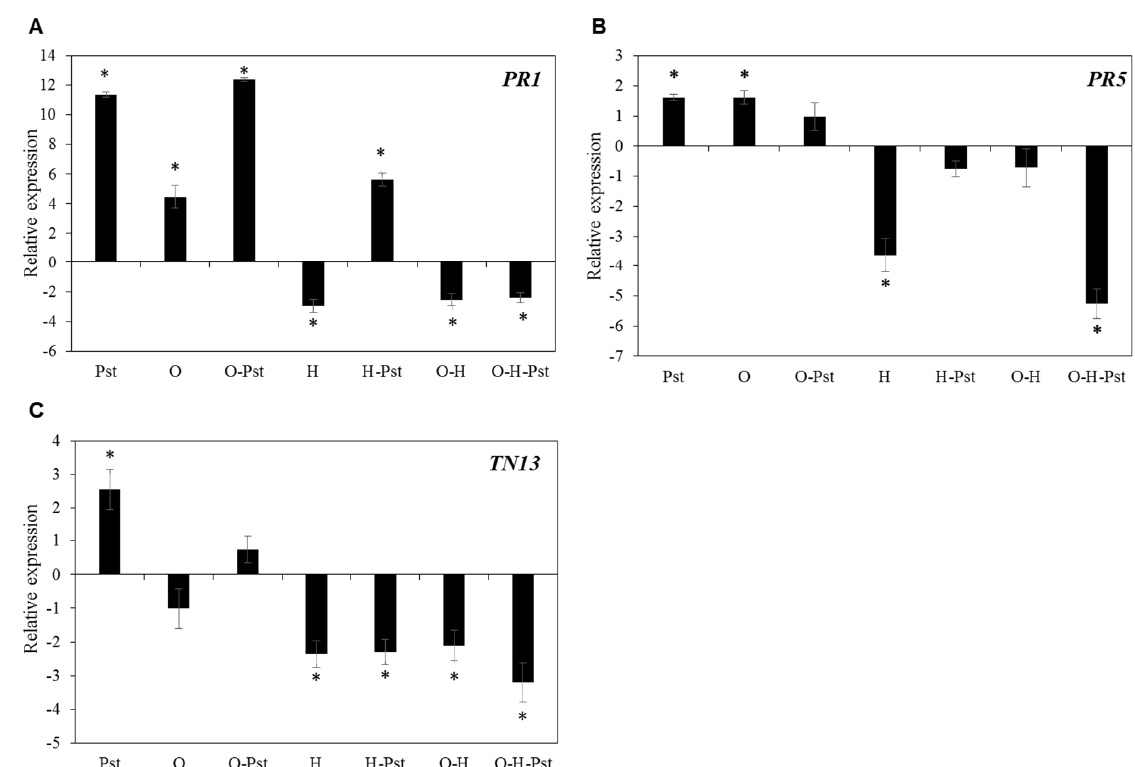
Figure 3. Effect of individual and combined osmotic, heat and Pseudomonas syringae pv. tomato DC3000 ( Pst ) treatments on the expression of AtPR-1 ( A ), AtPR-5 ( B ) and AtTN-13 ( C ) genes in Arabidopsis (Col-0) plants. Pst was applied 16 h after the abiotic stress treatments. Leaves were sampled 48 h after MgCl 2 (mock) or Pst treatments. O: osmotic stress, H: heat. Data are represented as log2 fold change, normalized with reference gene (plant biomass expressed protein, expG) and relative to the mock-treated control. The zero-line represents MgCl 2 -infiltrated (mock) plants. Bars represent the mean and standard deviation of three biological replicates. Asterisks indicate significant differences, 1-way ANOVA; post-hoc LSD, * p < 0.05.